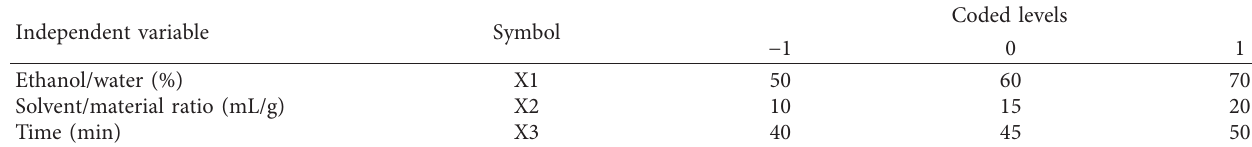
Table 1: Levels of variables for the experimental design.